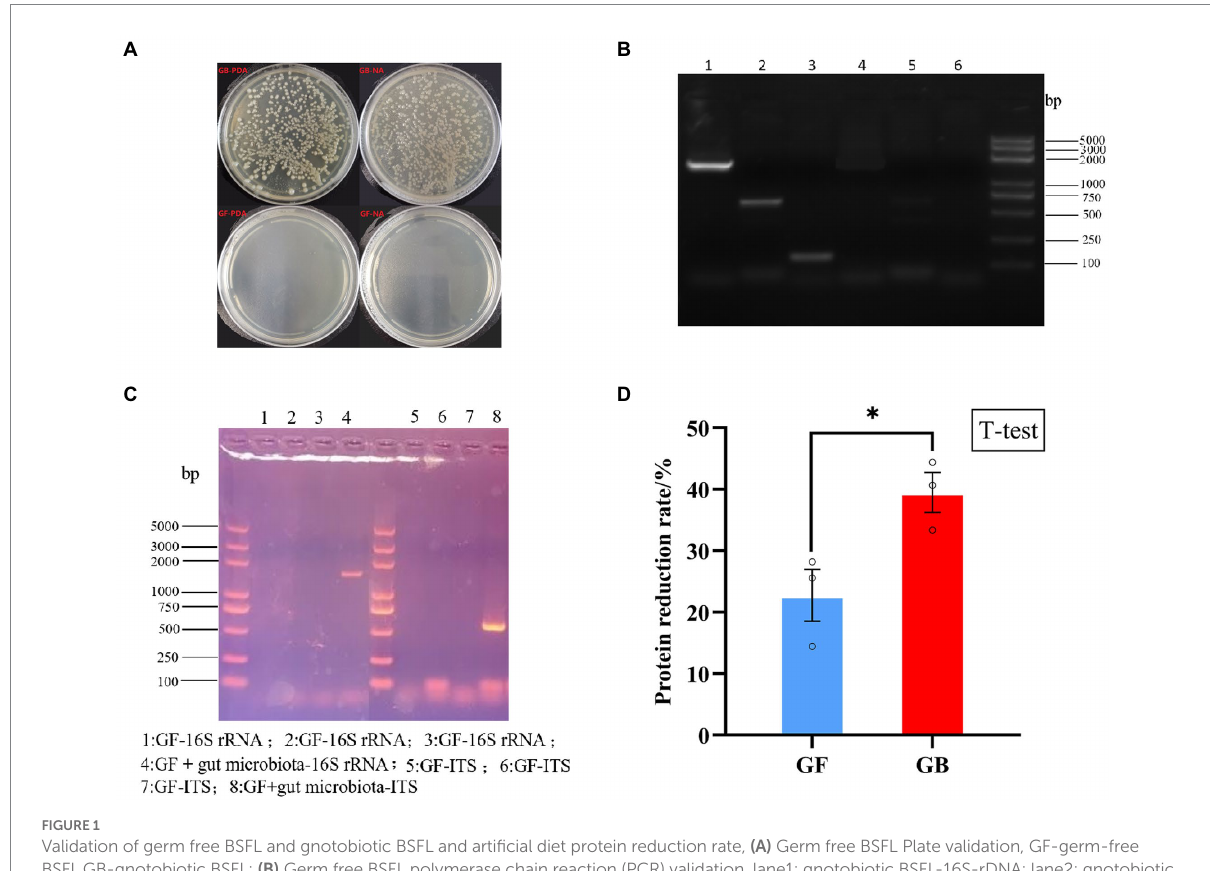
FIGURE 1 Validation of germ free BSFL and gnotobiotic BSFL and artificial diet protein reduction rate, (A) Germ free BSFL Plate validation, GF-germ-free BSFL,GB-gnotobiotic BSFL; (B) Germ free BSFL polymerase chain reaction (PCR) validation, lane1: gnotobiotic BSFL-16S-rDNA; lane2: gnotobiotic BSFL-ITS; lane3: gnotobiotic BSFL –Tubulin; lane4: Germ free BSFL-16S-rDNA; lane 5: Germ free BSFL-ITS; lane6: Germ free BSFL –Tubulin; (C) Germ free BSFL and gnotobiotic BSFL polymerase chain reaction (PCR) validation after the end of conversion; (D) GF-germ-free BSFL; GB-gnotobiotic BSFL, * p ≤ 0.05.